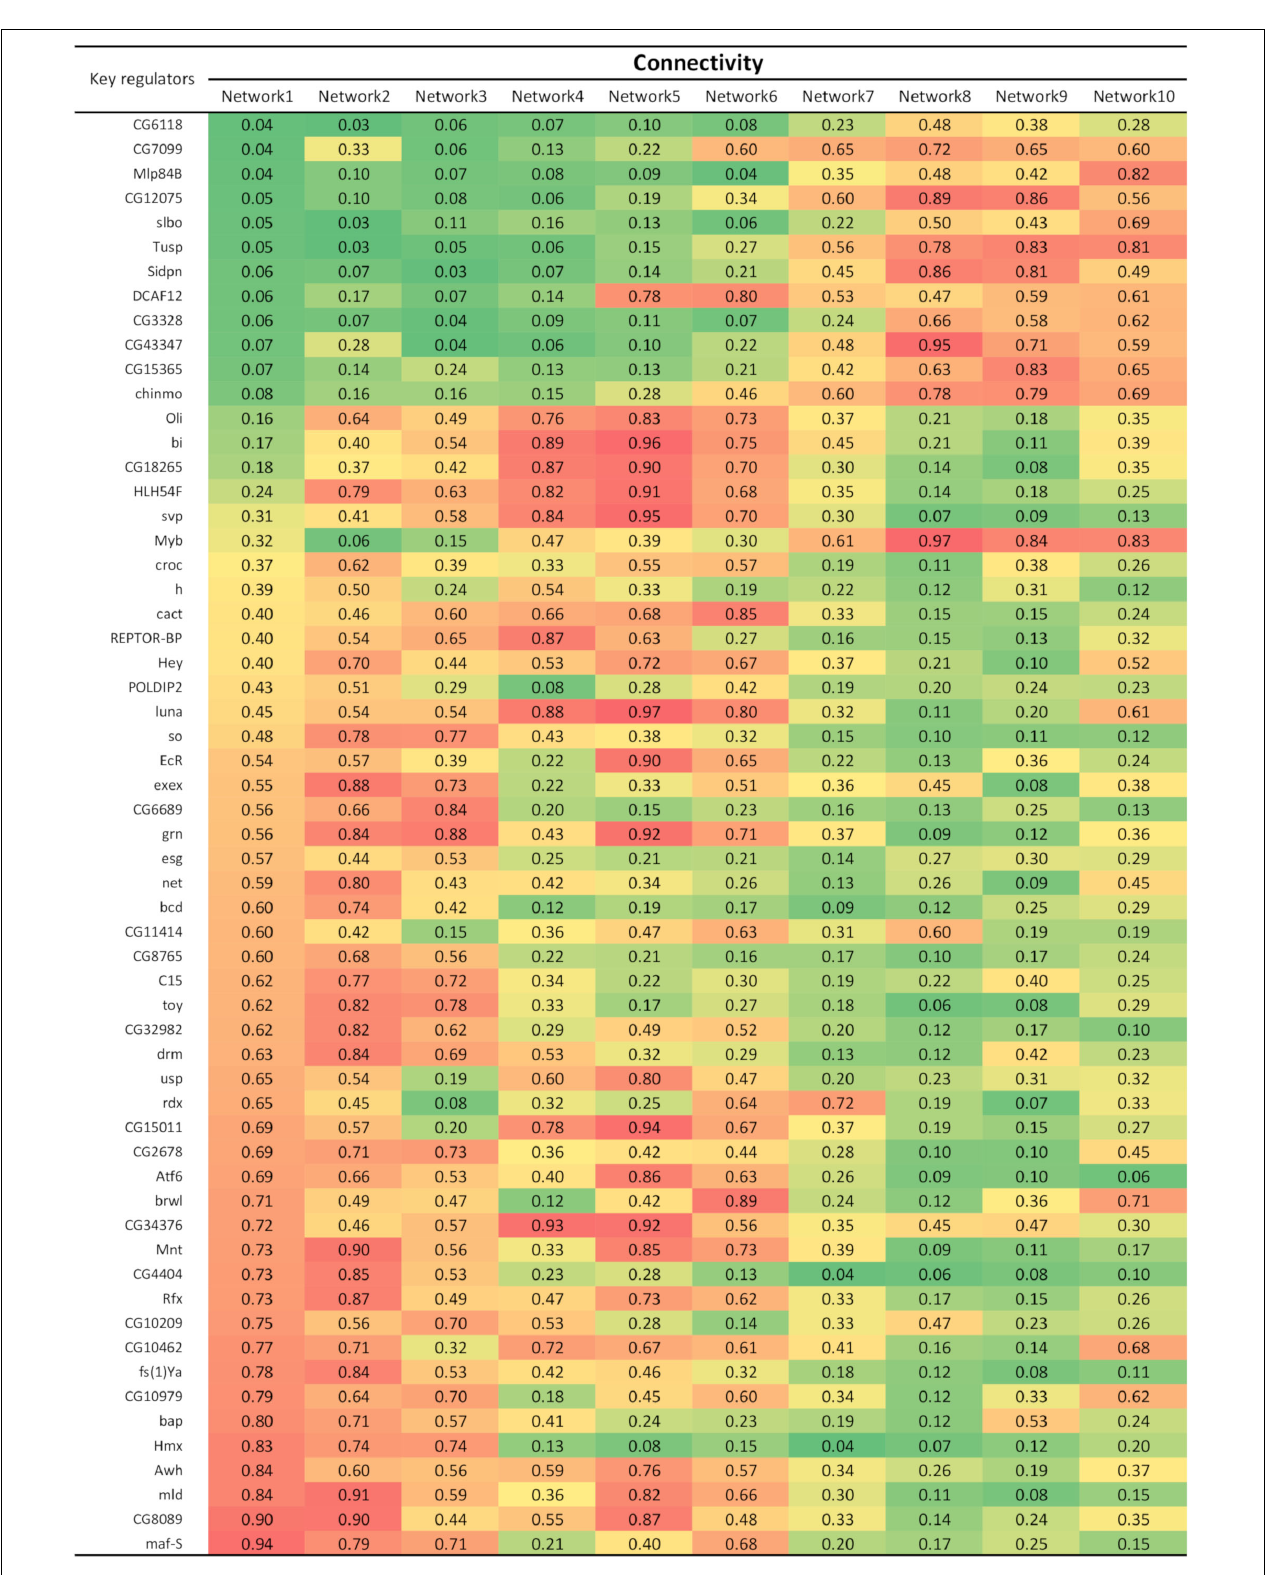
FIGURE 2 | Connectivity of the 59 key regulators in each network. Connectivity was calculated as the number of significant connections of a gene divided by the number of significant connections of the most connected gene in the network.